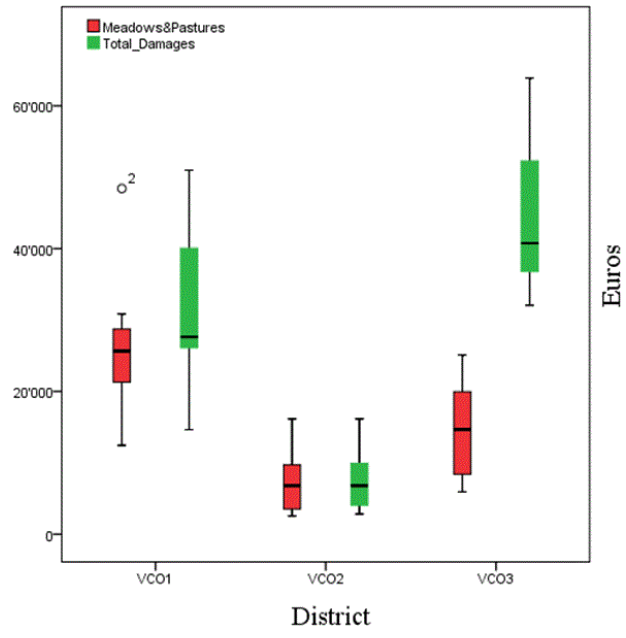
Fig. 6. Amount (in Euros) refunded to farmers by the state for damages caused by wild boar to agriculture in general (Total_damages) and to meadows and pastures in particular in the three VCO hunting districts during 2004–2014. Both VCO1 and VCO3 had greater mean reimbursed amounts for damages than VCO2, even though boar hunting is forbidden in